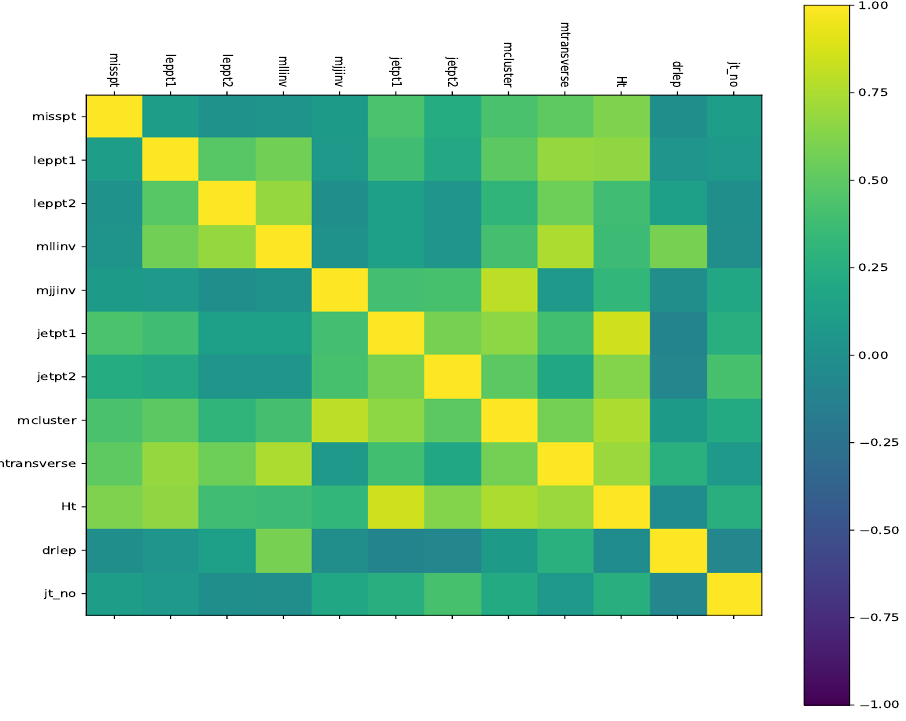
Figure 18 . Correlation matrix between the feature variables using